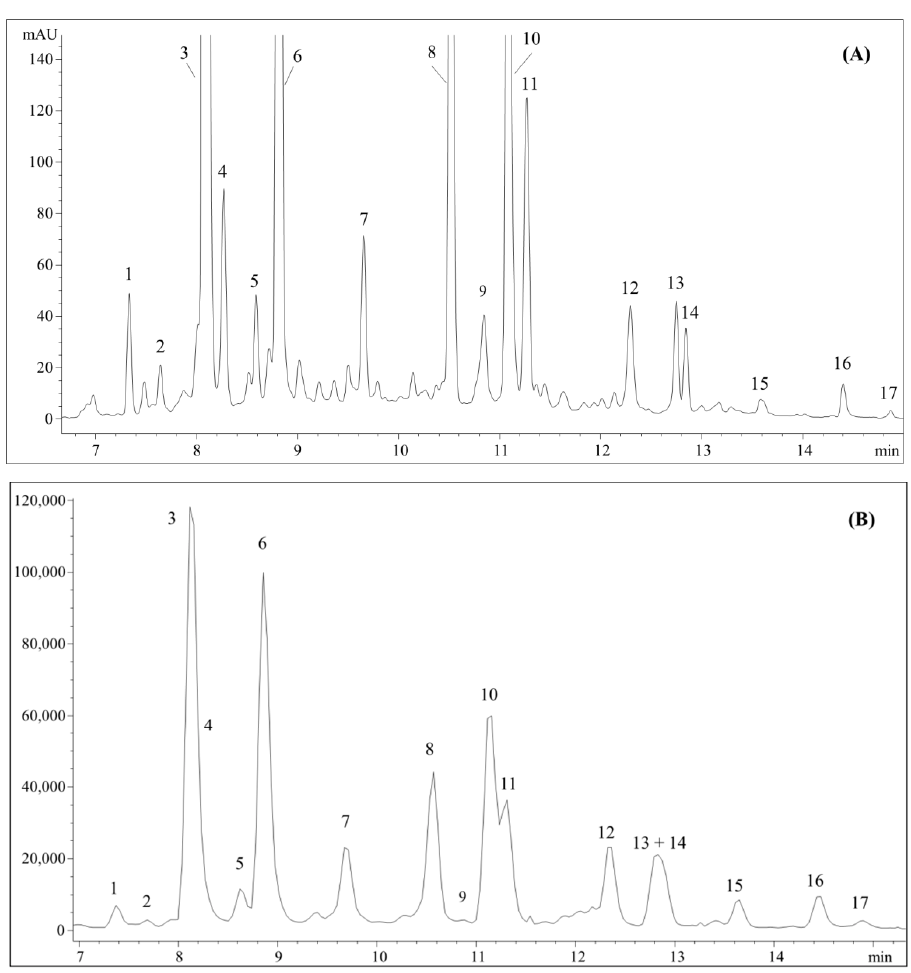
Figure 2. Crocins identified in the standardized saffron extract affron ® : ( A ) DAD signal at 440 nm; ( B ) MS signal corresponding to the extracted ion chromatogram at 329.1747 m/z . The peak assignations can be seen in Table 1.